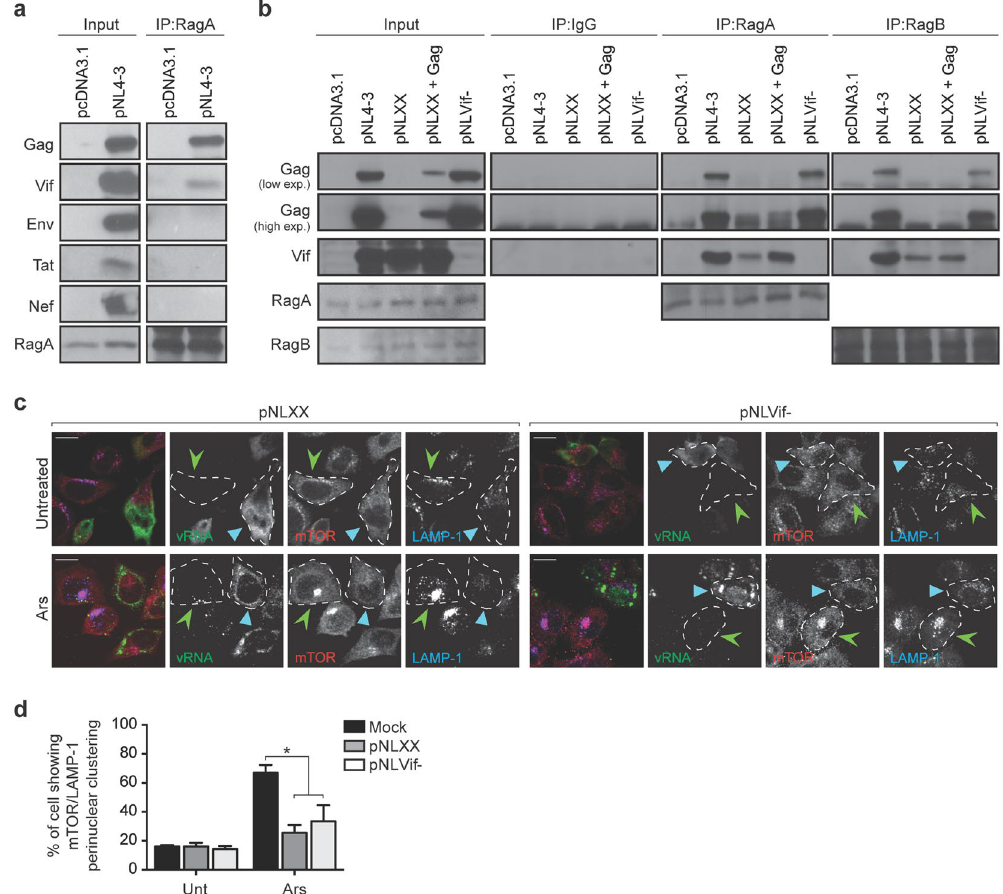
Figure 6. RagA and RagB interact with Gag and Vif. ( a ) Lysates from control pcDNA3.1- or pNL4-3- transfected HeLa cells were subjected to immunoprecipitation with RagA antibodies. Samples were subjected to SDS-PAGE followed by transfer to nitrocellulose membranes and probed with the indicated antibodies. Full- length blots are shown in Supplementary Fig. 5. ( b ) Lysate from pcDNA3.1-, pNL4-3-, pNLXX − , pNLXX + pSVGag − and pNLVif–transfected HeLa cells were subjected to immunoprecipitation with RagA and RagB antibodies or isotype rabbit IgG control. The blots were probed with anti-p24, anti-Vif, anti-RagA and anti- RagB antibodies. Full-length blots are shown in Supplementary Fig. 5. ( c ) HeLa cells were transfected with either pNLXX or pNLVif- and left untreated (Unt) or stressed with 500 µ M Ars for 1 h. HIV-1-expressing cells were identified using FISH to localize vRNA and stained using antibodies against mTOR (Cell Signaling) and LAMP-1. Light blue arrowheads identify pNLXX or pNLVif- expressing cells, while pNLXX or pNLVif- negative cells in the same field are indicated with green arrowheads. A dashed line contours individual cells. Scale bars are 10 μ m. ( d ) The percentage of mock, pNLXX or pNLVif- transfected cells showing perinuclear clustering of mTOR/LAMP-1 from panel c. The results are presented as the mean ± S.D. from three different experiments. P value is indicated by * (p <